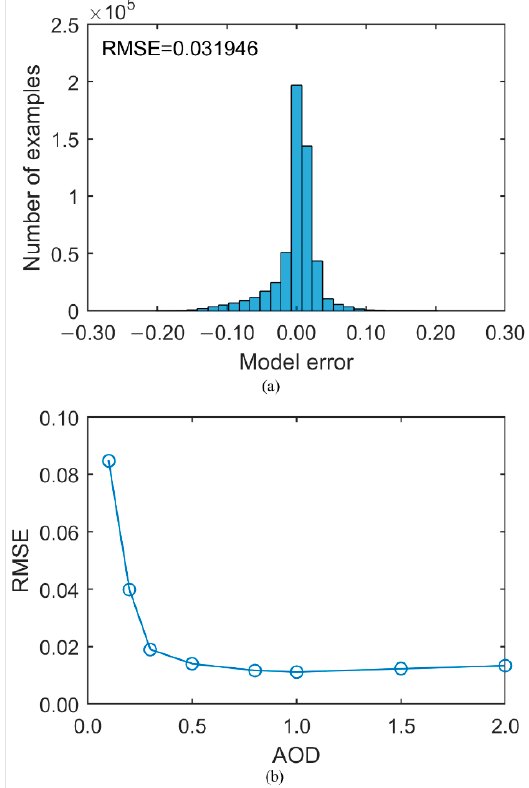
Figure 5. ( a ) The error distribution histogram of the ANN model. ( b ) Relationship between RMSE and AOD (environmental parameter settings: solar zenith angle = 20°, sensor zenith angle = 40°, relative azimuth angle = 60°).